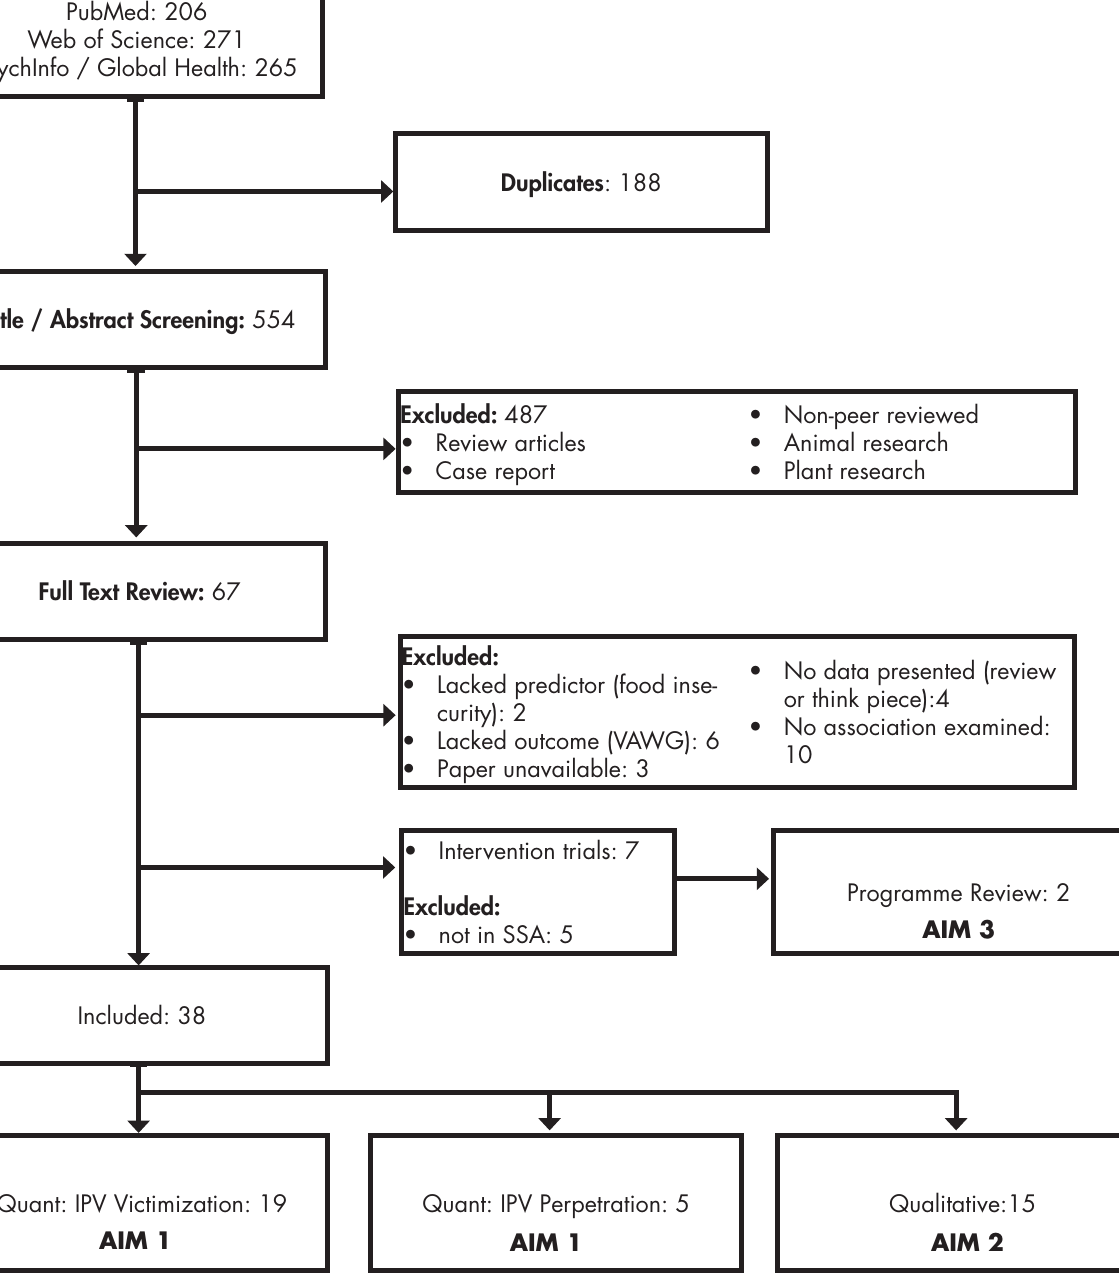
Fig 1. Study selection flow